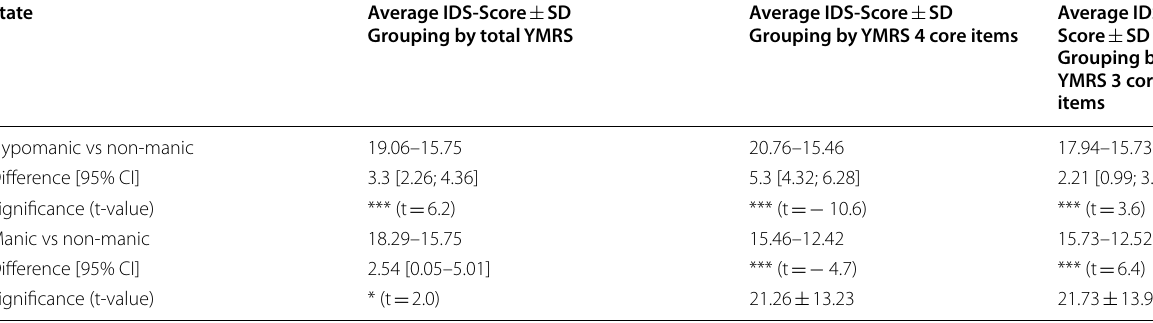
Table 3 Differences in mean IDS-C scores for the YMRS-groups (total and core items) EVEN